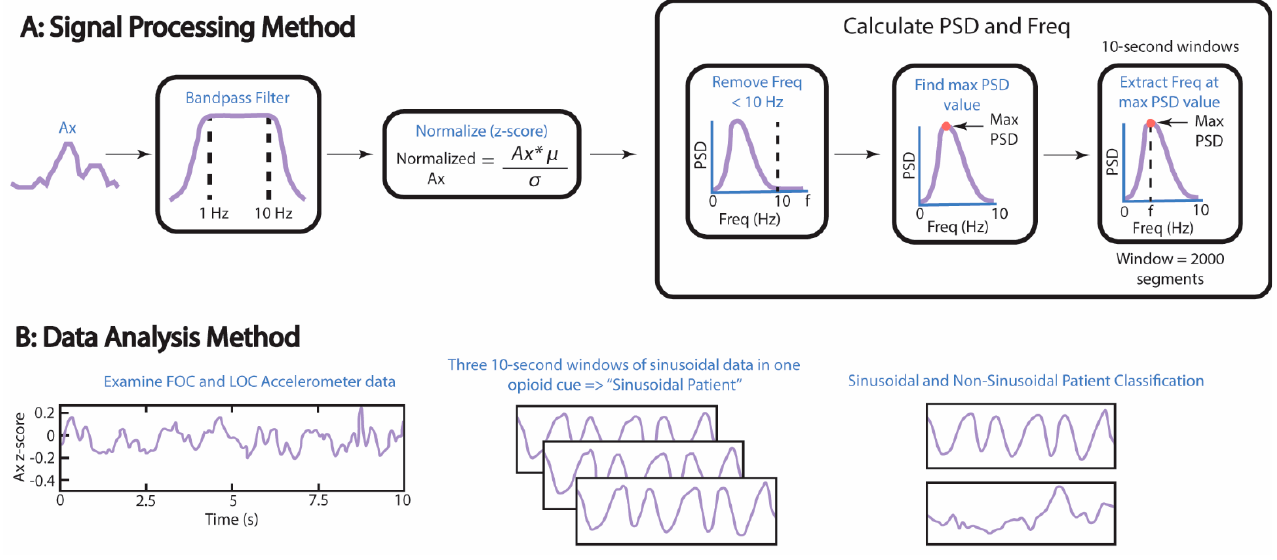
Figure 3. Methods used to find significant correlations between the COWS scores and the normalized max PSD, as well as the correlations between the frequency at the max PSD and the normalized max PSD. ( A ) Accelerometer data were normalized using z-score normalization, where μ = mean and σ = standard deviation. The maximum PSD of a 10 − s window was normalized to the summation of all PSD values within the same window. Freq = frequency. ( B ) Processed data were analyzed by visual inspection for sinusoidal patterns in the accelerometer data lasting ≥ 5 s in a 10 − s window. A patient was labeled a “Sinusoidal Patient” if three or more windows containing the aforementioned pattern were found in the first opioid cue (FOC) or last opioid cue (LOC) of their accelerometer data.